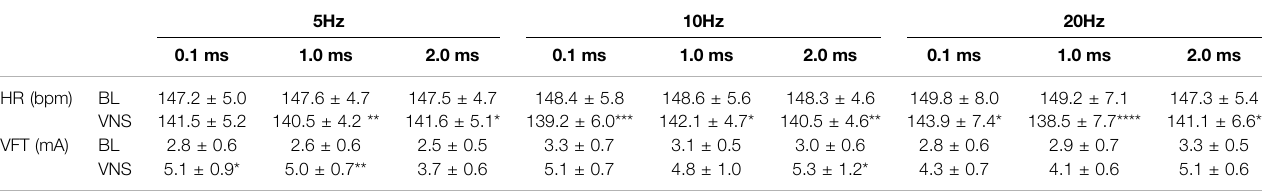
TABLE2| TheeffectsoflowvoltageandhighfrequencyVNSonHRandVFT.HRchangesfrombaseline(BL)toVNSat5(A),10(B)and20 Hz(C)atstimulationpulsewidths of0.1,1and 2 ms.VFTchangesfrombaseline(BL)toVNSat5(D),10(E)and20 Hz(F)atstimulationpulsewidthsof0.1,1and2 ms.Datarepresentmean±SEM.* p